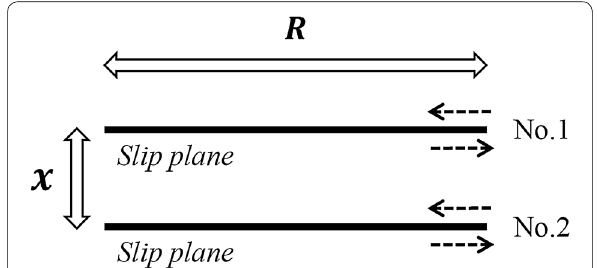
Fig. 1 Parallel fault model in this study. Two shear faults (No. 1 & 2) of length R are set at a distance of x , and not